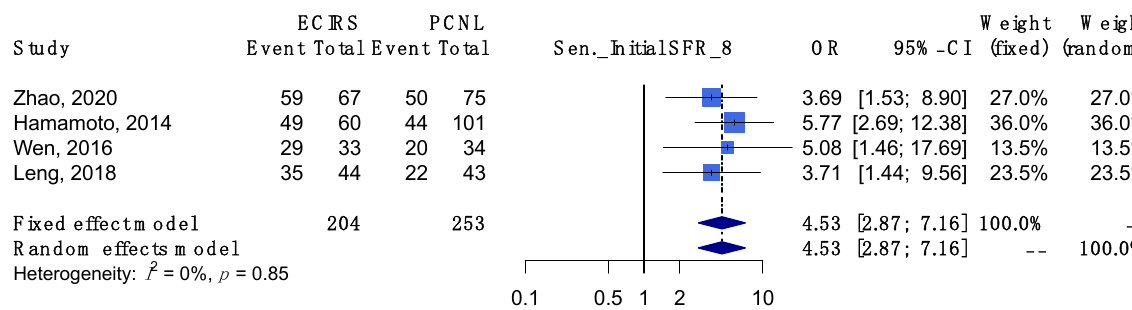
Figure A28. Sensitivity analysis of outcome regarding initial stone free rate. ([17–19,22])